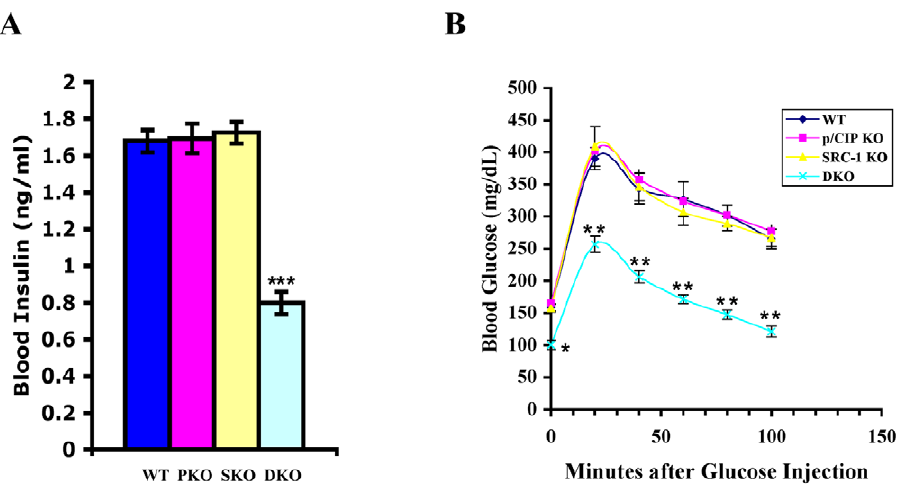
doi:10.1371/journal.pone.0036961.g004